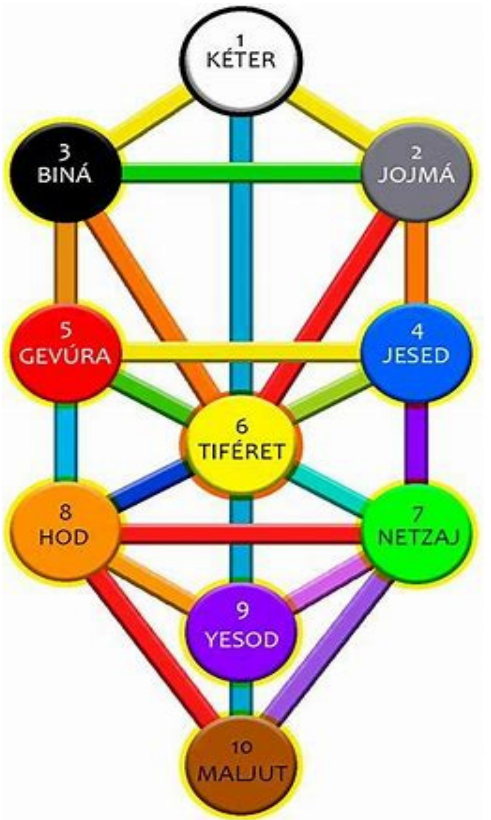
Figure 1. The tree of life.